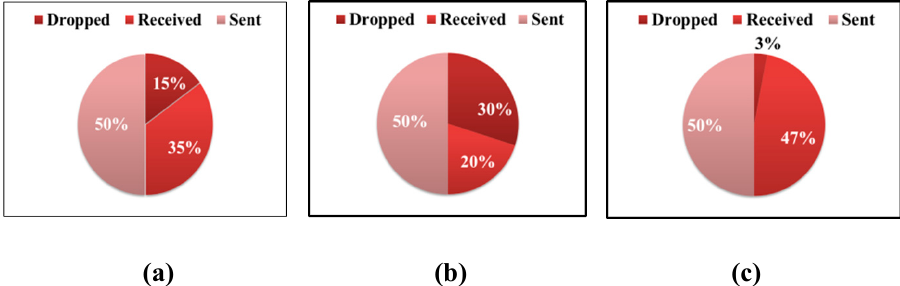
Figure 10. Changing the pattern of traffic for the network under the Black-Hole attack with a change in the number of malicious nodes: ( a ) for three malicious hosts; ( b ) for nine malicious hosts; ( c ) when malicious nodes were missing.